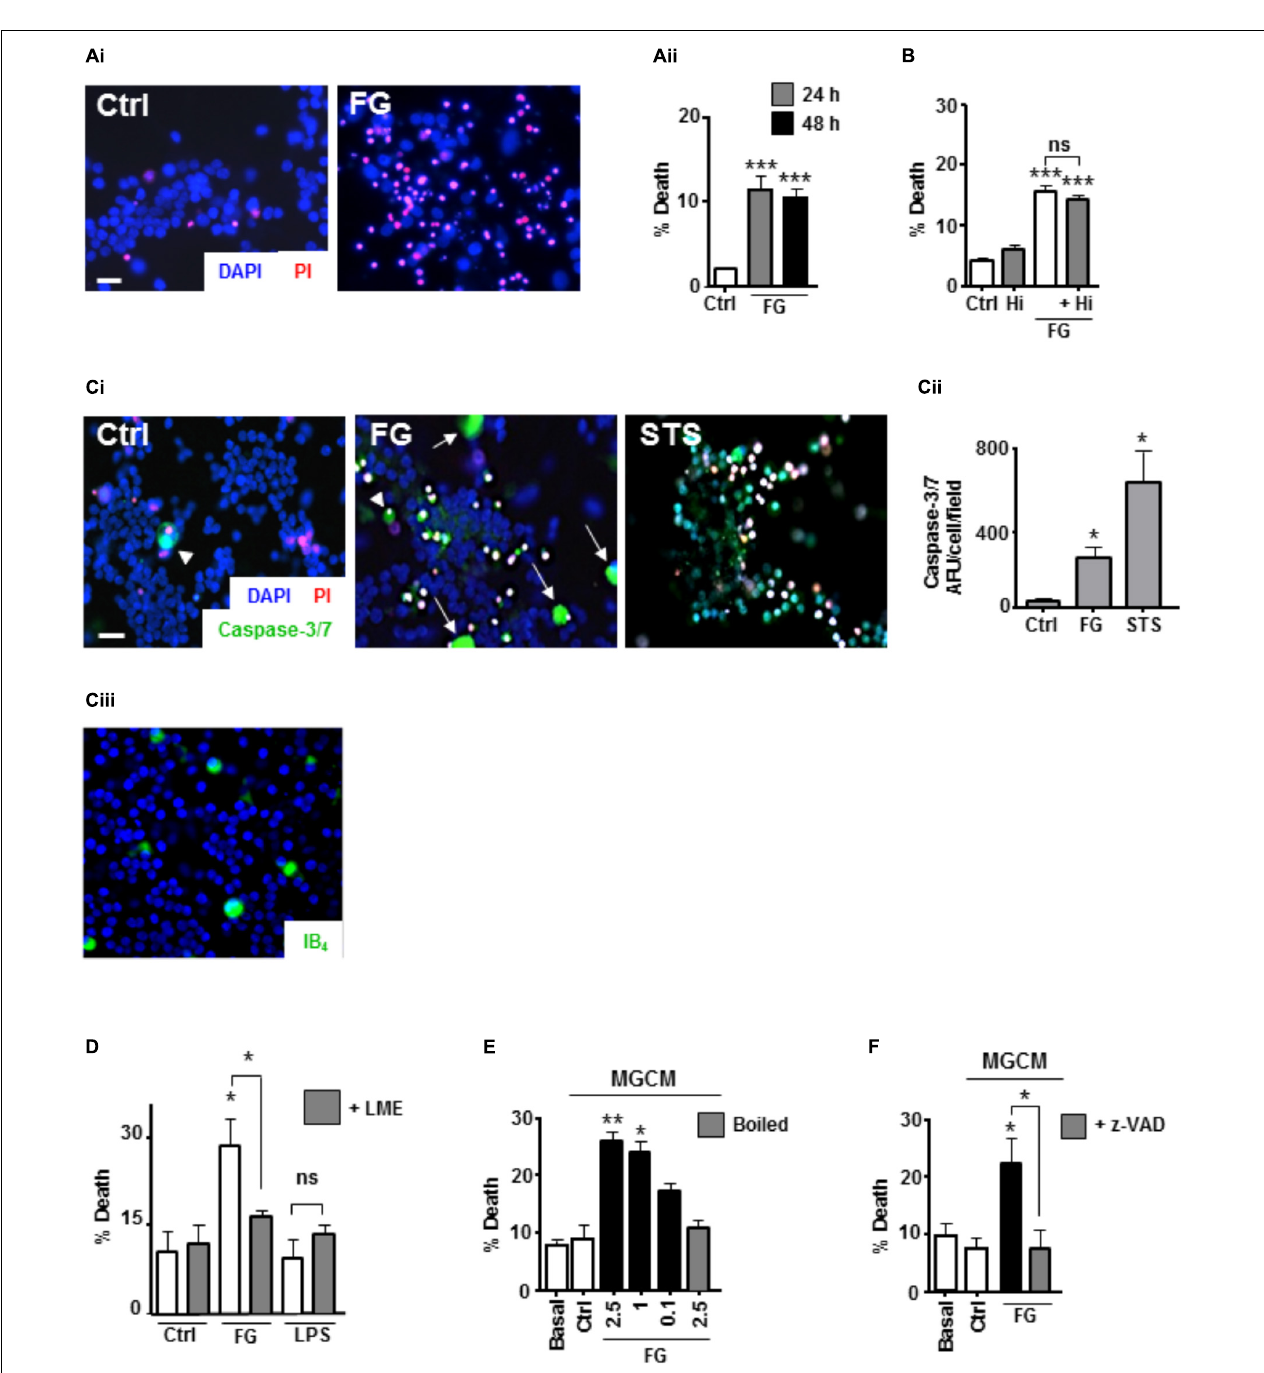
FIGURE 3 | FG-mediated neurotoxicity is dependent on secreted microglial factors. (A) Live cell staining with propidium iodide (PI) of ENGCs for analysis of cellular death after FG treatment for 24–48 h (Scale bar: 15 µ m; Ai ), quantified as a percentage of PI + cells in the population ( Aii ). (B) Quantification of cell death in ENGCs after treatment with 2.5 mg/ml FG for 24 h + /– hirudin (40 U/ml). (C) Analysis of caspase 3/7 activity by FAM-DEVD-FMK live cell staining in ENGCs following exposure to FG (2.5 mg/ml) or staurosporine (STS, 0.5 µ M; Scale bar: 20 µ m) for 24 h, Ci . Data were quantified and presented as arbitrary fluorescence units (AFU)/cell/field of view; Cii ). Confirmation of the presence of microglia in ENGCs with IB 4 cell staining ( Ciii ). All cellular populations were counterstained with Hoechst 33342 (blue). (D) Assessment of ENGC death by PI live cell staining after treatment with FG (2.5 mg/ml) or LPS (1 µ g/ml) for 24 h before and after microglial ablation ( + LME). (E) Analysis of ENGC death by PI live cell staining after exposure to microglial conditioned medium (MGCM) collected from cultures treated for 24 h with FG (0.1–2.5 mg/ml) or untreated (Ctrl). Some MGCM samples from FG treated cultures were boiled to inactivate prior to addition. (F) Analysis of ENGC death by PI live cell staining after exposure to MGCM collected from cultures treated for 24 h with FG (2.5 mg/ml) + /– z-VAD-FMK, or untreated (Ctrl). In all graphs, data are the mean ± SEM from at least three independent experiments with internal replicates of at least 3. Significance levels are compared with control condition in each graph unless otherwise indicated, ∗ p < 0.05, ∗∗ p < 0.01, ∗∗∗ p < 0.001.